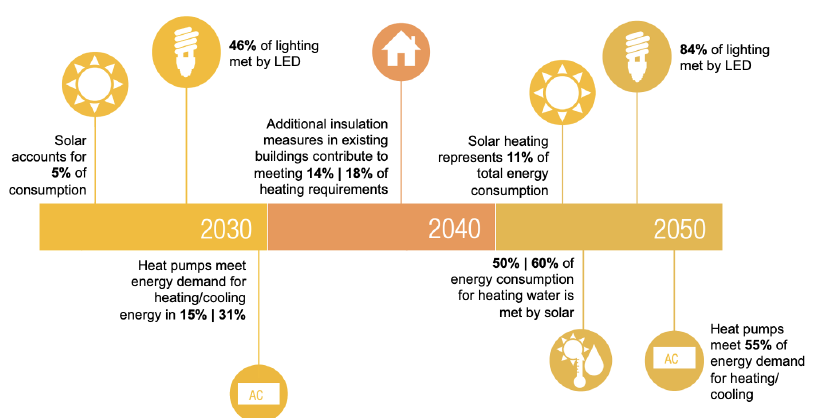
Figure 4. Timeline of service sector’s carbon neutrality pathway up to 2050, as defined by the RNC2050, adapted with permission from Ref.